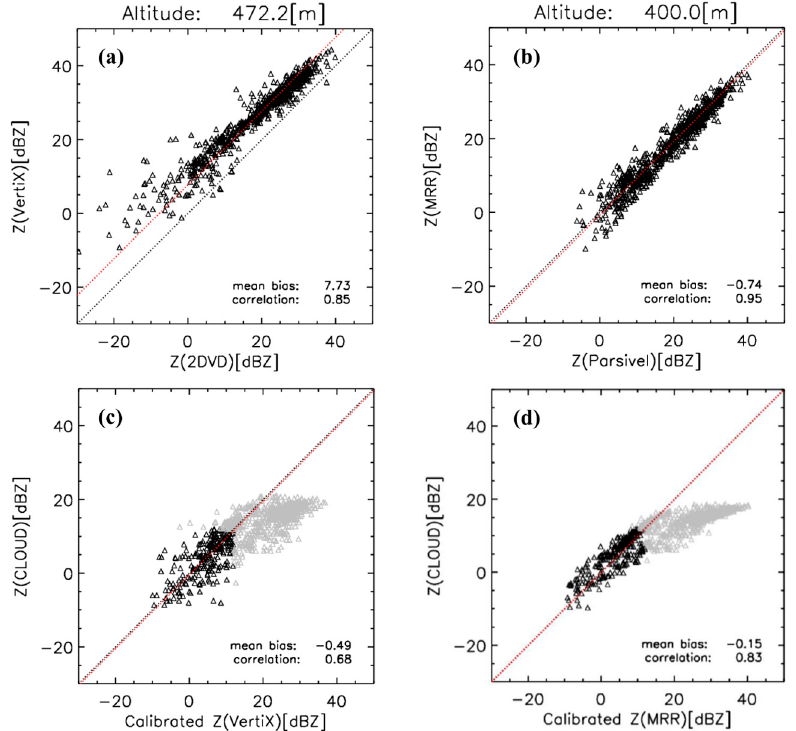
Figure 6. Scatter plots of radar reflectivity derived from 0400 to 1600 UTC, 2 July, 2014. ( a ) 2DVD vs. VertiX, ( b ) PARSIVEL vs. MRR, ( c ) calibrated VertiX vs. cloud radar, and ( d ) calibrated MRR vs. cloud radar. The mean bias is shown in the red line.